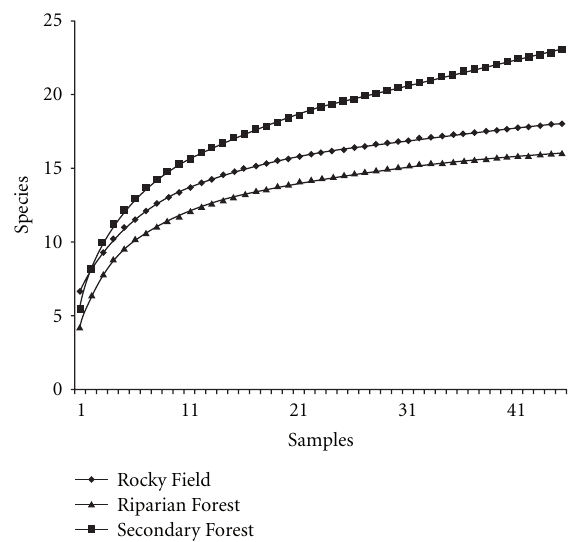
Figure 2: Sample-based rarefaction curves for the ant species at three phytophysionomies at Parque Estadual do Ibitipoca—Brazil. July–December,